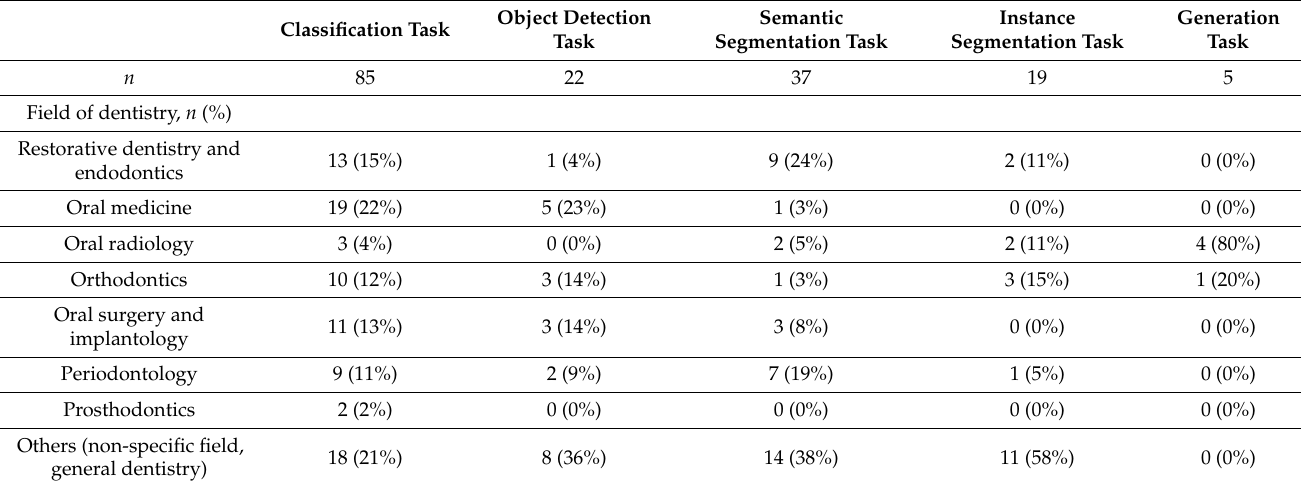
Table 2. Number of studies in each field of dentistry, stratified by type of machine learning task ( n = 168). Classification